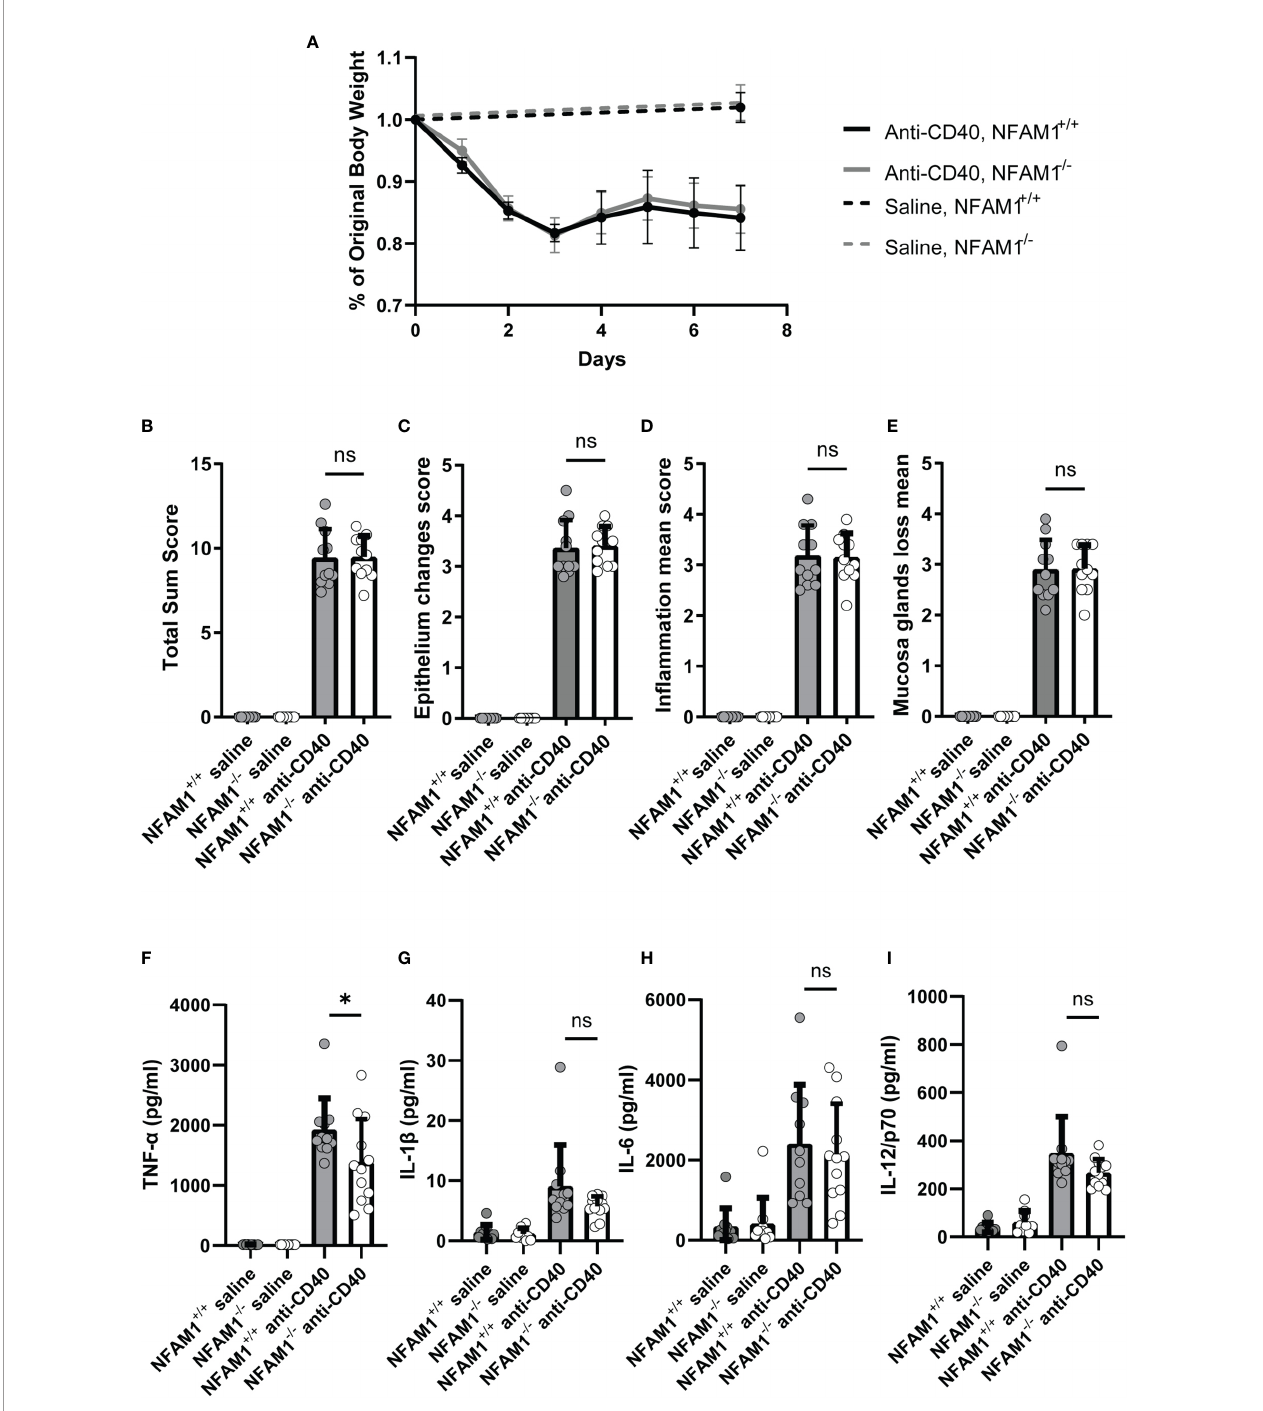
FIGURE 9 | Induction of anti-CD40 colitis in NFAM1 -/- mice results in decreased production of TNF- a but no signi fi cant difference in development of gut pathology. (A – I) 9 NFAM1 +/+ RAG2 -/- mice and 9 NFAM1 -/- RAG2 -/- mice were injected with saline and weighed on days 0 and 7. 11 NFAM1 +/+ RAG2 -/- mice and 12 NFAM1 -/- RAG2 -/- mice were injected with anti-CD40 and weighed daily on days 0-7. Mean percent of original body weight is shown in (A) . Mean gut sum pathology scores are shown in (B) , mean epithelial change scores are shown in (C) , mean in fl ammation scores are shown in (D) , mean mucosal gland loss scores are shown in (E) . Serum TNF- a , IL-1 b , IL-6 and IL-12 are shown in (F – I) , respectively. Data are representative of two independent experiments. In the second experiment (data not shown), there was also a statistically signi fi cant decrease in anti-CD40 induced TNF- a production in NFAM1 -/- mice. Statistical signi fi cance is depicted as follows: * indicates a P value of <0.05 and ns indicates the comparison is not statistically signi fi